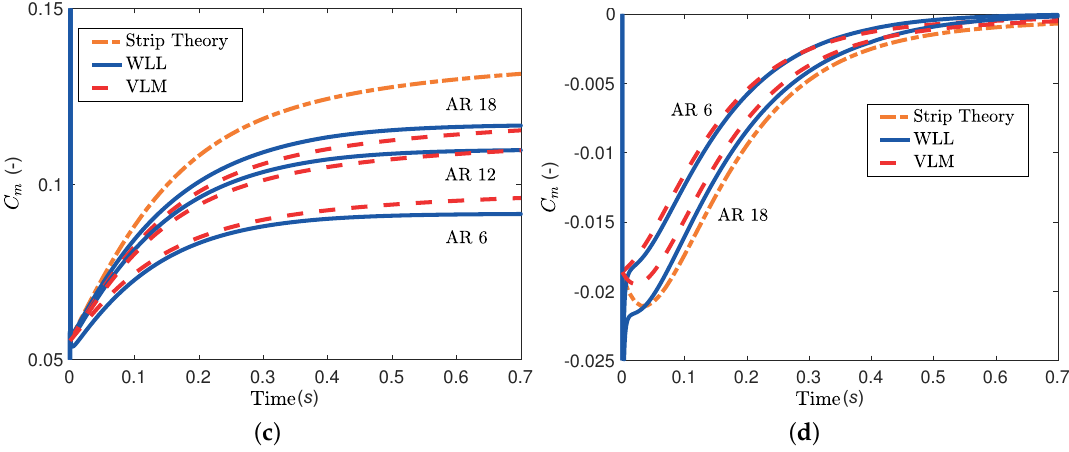
Figure 7. Comparison between VLM, WLL and strip theory for a rectangular wing undergoing a step motion. ( a ) Lift coefficient, pitch step A = 5 ◦ ; ( b ) Lift coefficient, plunge step A = 0.1 m; ( c ) Moment coefficient, pitch step A = 5 ◦ ; ( d ) Moment coefficient, plunge step A = 0.1 m.